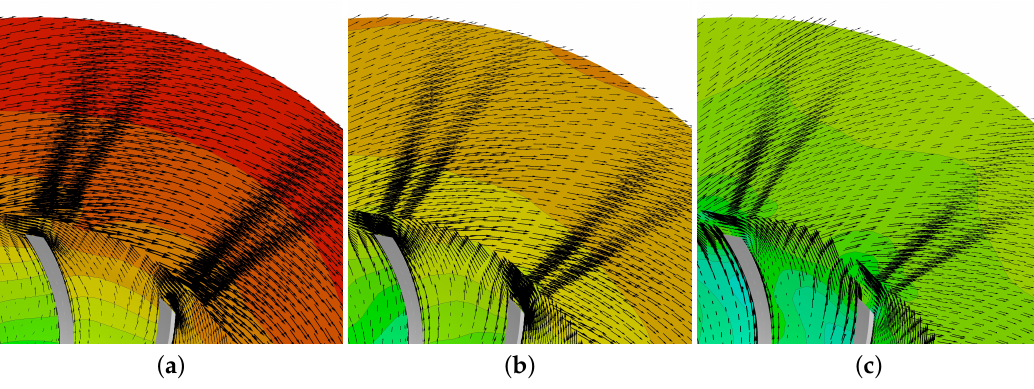
Figure 19. Velocity vectors near trailing edge of the main blade for vaneless configuration. ( a ) Vaneless diffuser at mass flow rate of 1.4 kg/s. ( b ) Vaneless diffuser at mass flow rate of 2.9 kg/s. ( c ) Vaneless diffuser at mass flow rate of 4.5